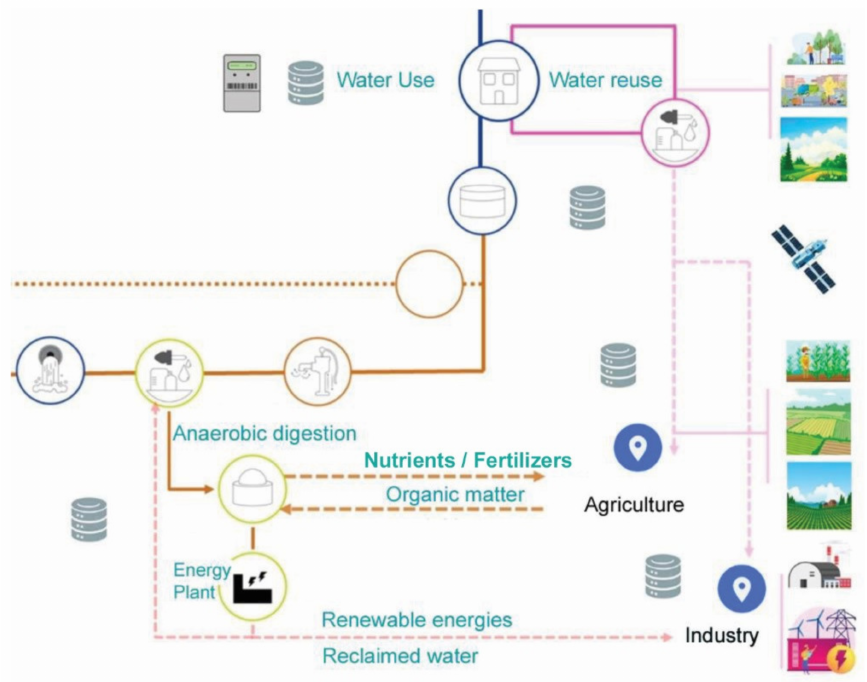
Figure 4. Digitization and reuse: Urban uses, agriculture, and